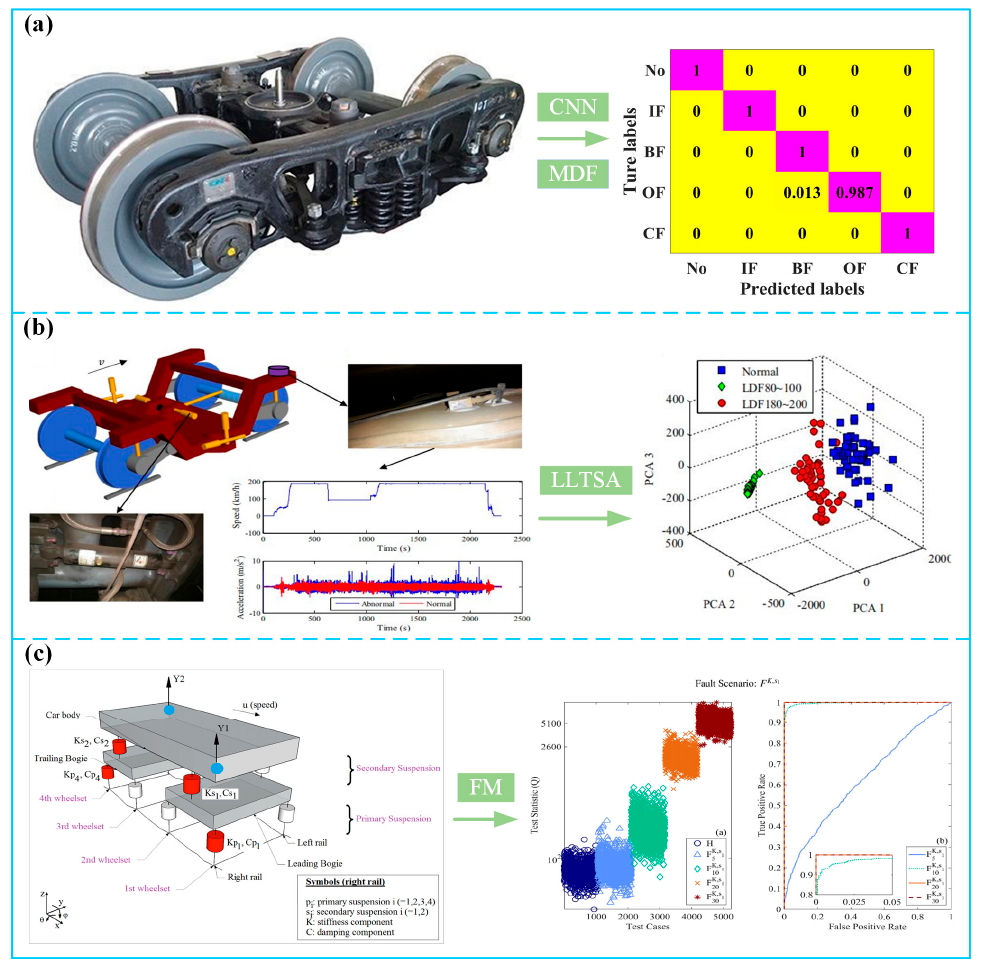
Figure 5. Fault diagnosis method of bogie suspension system: ( a ) multi-domain fusion (MDF)– convolutional neural network (CNN); ( b ) linear local tangent space alignment (LLTSA) [58]; ( c ) functional model (FM) [62].